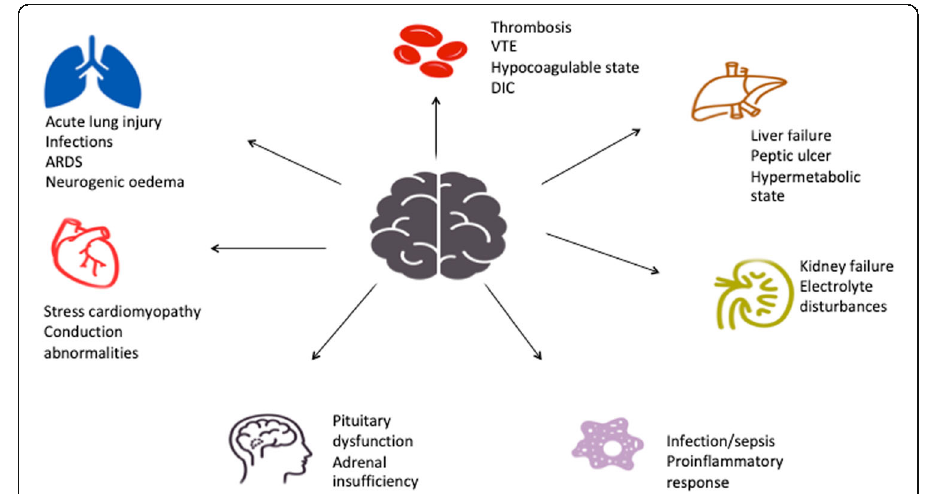
Fig. 1 Main types of peripheral organ dysfunction after